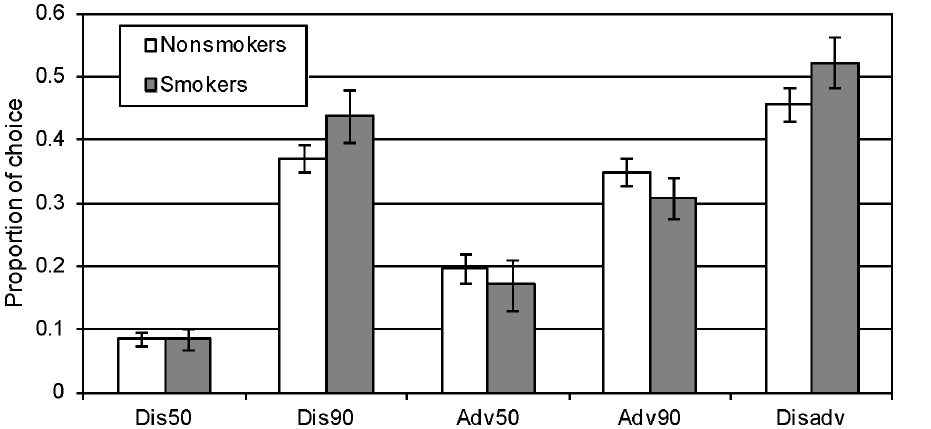
Figure 1. Smokers and nonsmokers’ choices from each of the decks of the modified IGT (average proportions and standard errors). The right column (Disadv) shows the proportion of choices from the disadvantageous decks (Dis50 + Dis90).